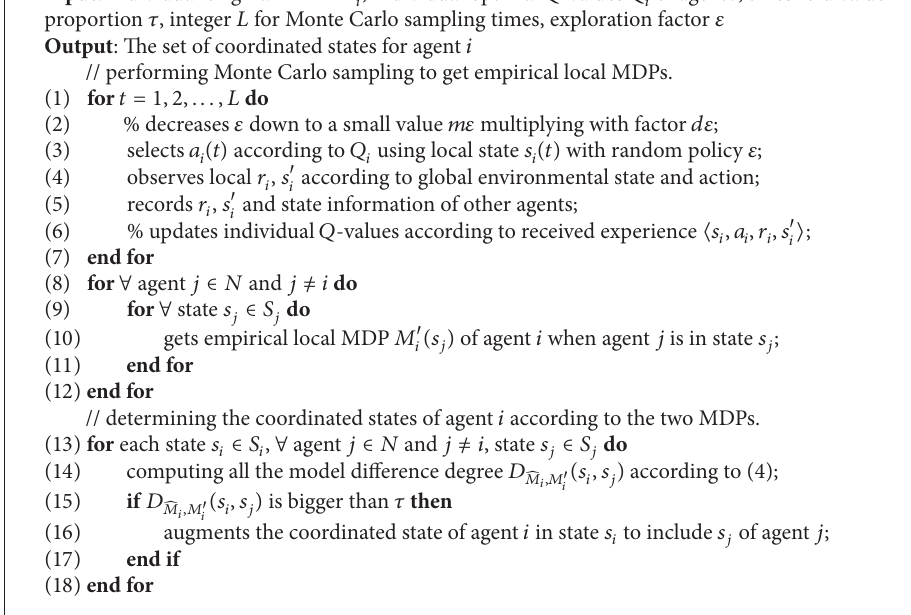
Algorithm 1: A model-based method for identifying coordinated states of agent 𝑖